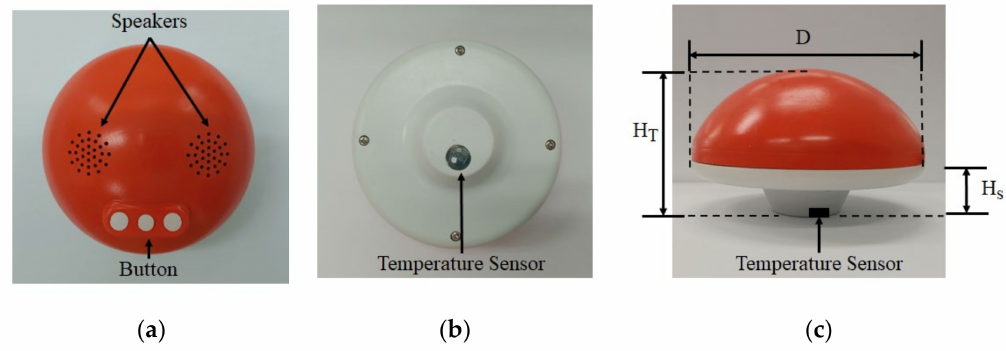
Figure 6. Pictures of assembled smart bath assistive device: (a) top view; (b) bottom view; and (c) lateral